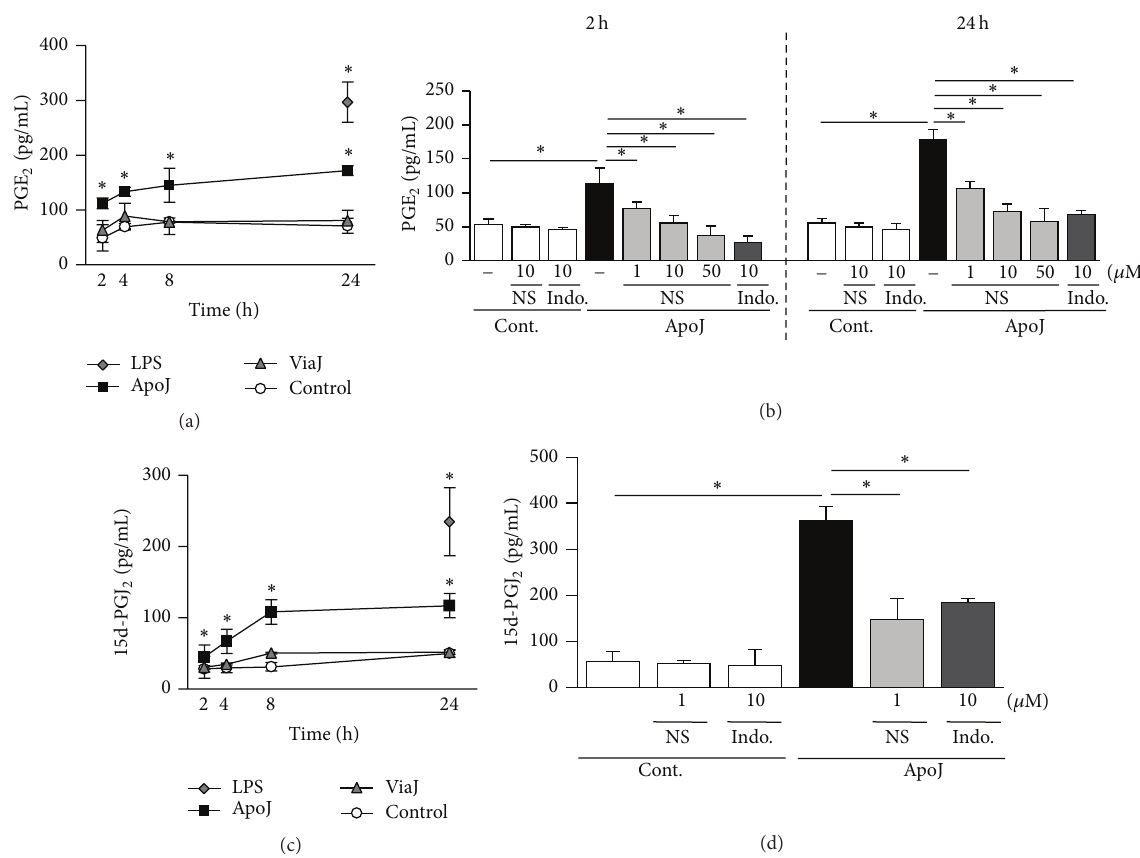
Figure 2: Apoptotic cells induce PGE 2 and 15d-PGJ 2 production by RAW 264.7 cells. (a, c) RAW 264.7 cells were stimulated by apoptotic (ApoJ), viable (ViaJ) Jurkat T cells, or lipopolysaccharide (LPS) for the times indicated. (b, d) After 1h pretreatment with 1–50 𝜇 M of NS-398 or 10 𝜇 M of indomethacin (Indo), RAW cells were stimulated with ApoJ for 2h or 24 h. PGE 2 or 15d-PGJ 2 levels in the conditioned media were measured by EIA. Values represent mean ± SEM of three or more separate experiments, ∗ 𝑃 < 0.05 , compared with control or ApoJ versus ApoJ + NS or